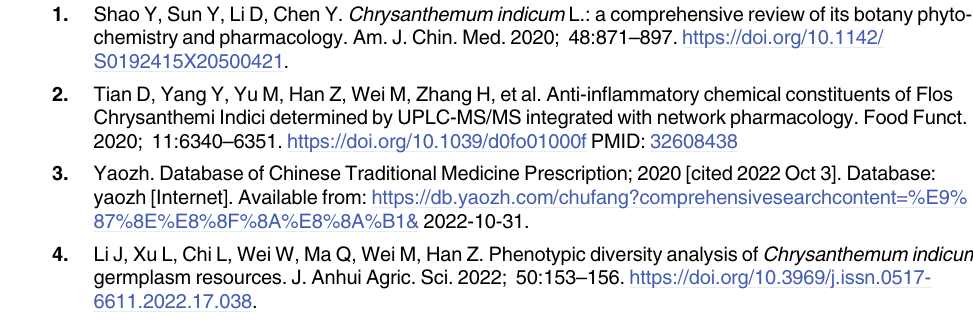
S1 Table. Precision of CIF sample constituents in each measurement under UPLC condi- tions. S2 Table. Stability of the nine constituents under UPLC conditions. S3 Table. Recoveries of the nine constituents under UPLC